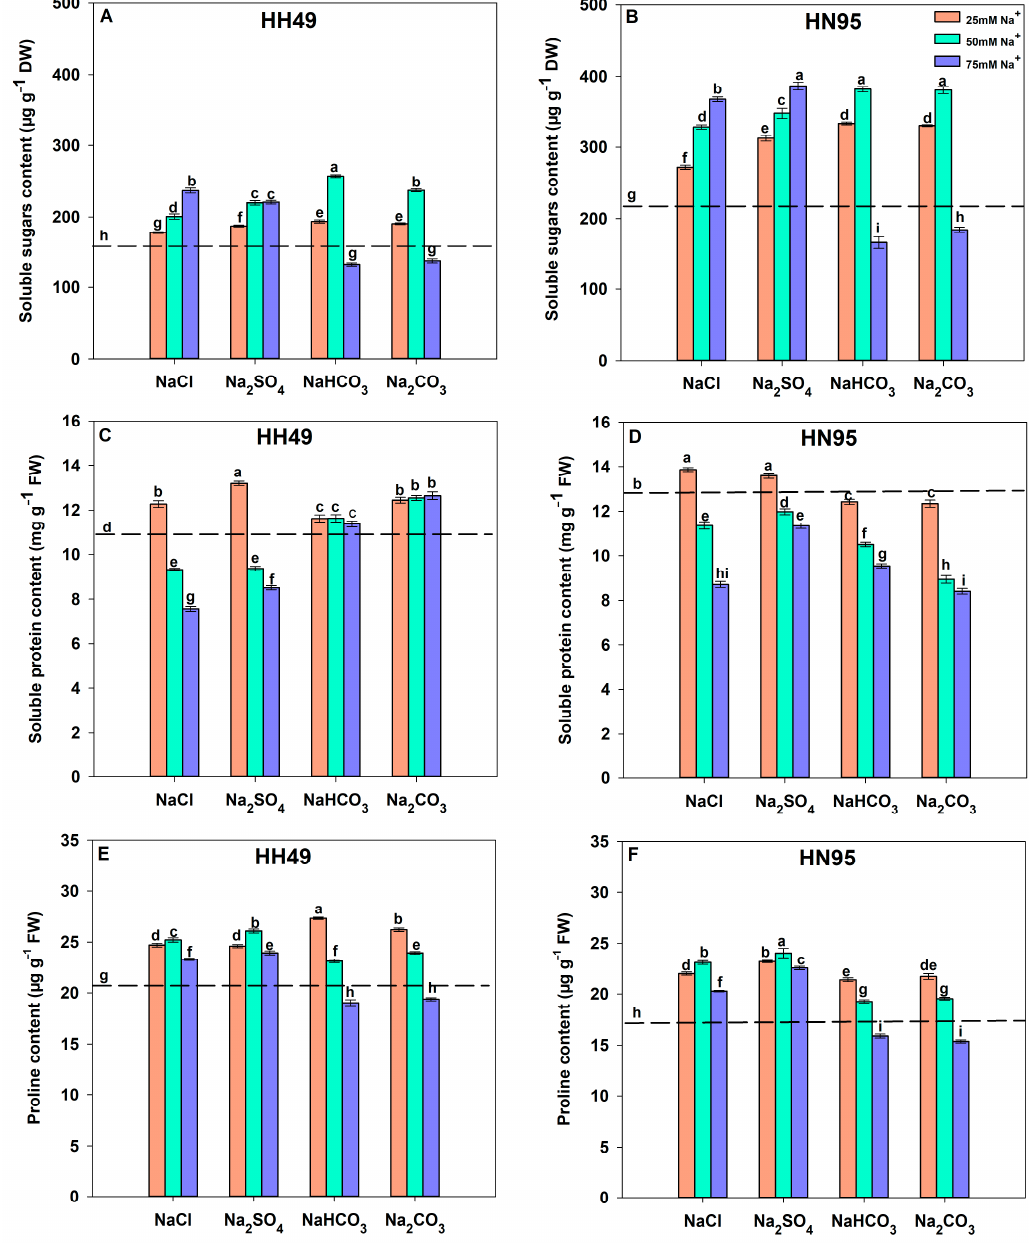
Figure 5. The osmotic regulation of soybean seedling roots treated with different salt stresses for 3 days. The content of soluble sugars ( A ), soluble protein ( C ), and proline ( E ) in HH49 seedling roots treated with different Na + concentration solutions in formulas of NaCl, Na 2 SO 4 , NaHCO 3 , and Na 2 CO 3 . The content of soluble sugars ( B ), soluble protein ( D ), and proline ( F ) in HN95 seedling roots treated with different Na + concentration solutions in formulas of NaCl, Na 2 SO 4 , NaHCO 3 , and Na 2 CO 3 . Dashed lines in ( A – F ) indicate the content of soluble sugars, soluble protein, and proline in HH49 and HN95 seedling roots under the control conditions. Data are expressed as means ± SD of three independent experiments. Different letters indicate statistically significant differences ( p < 0.05) among treatments.